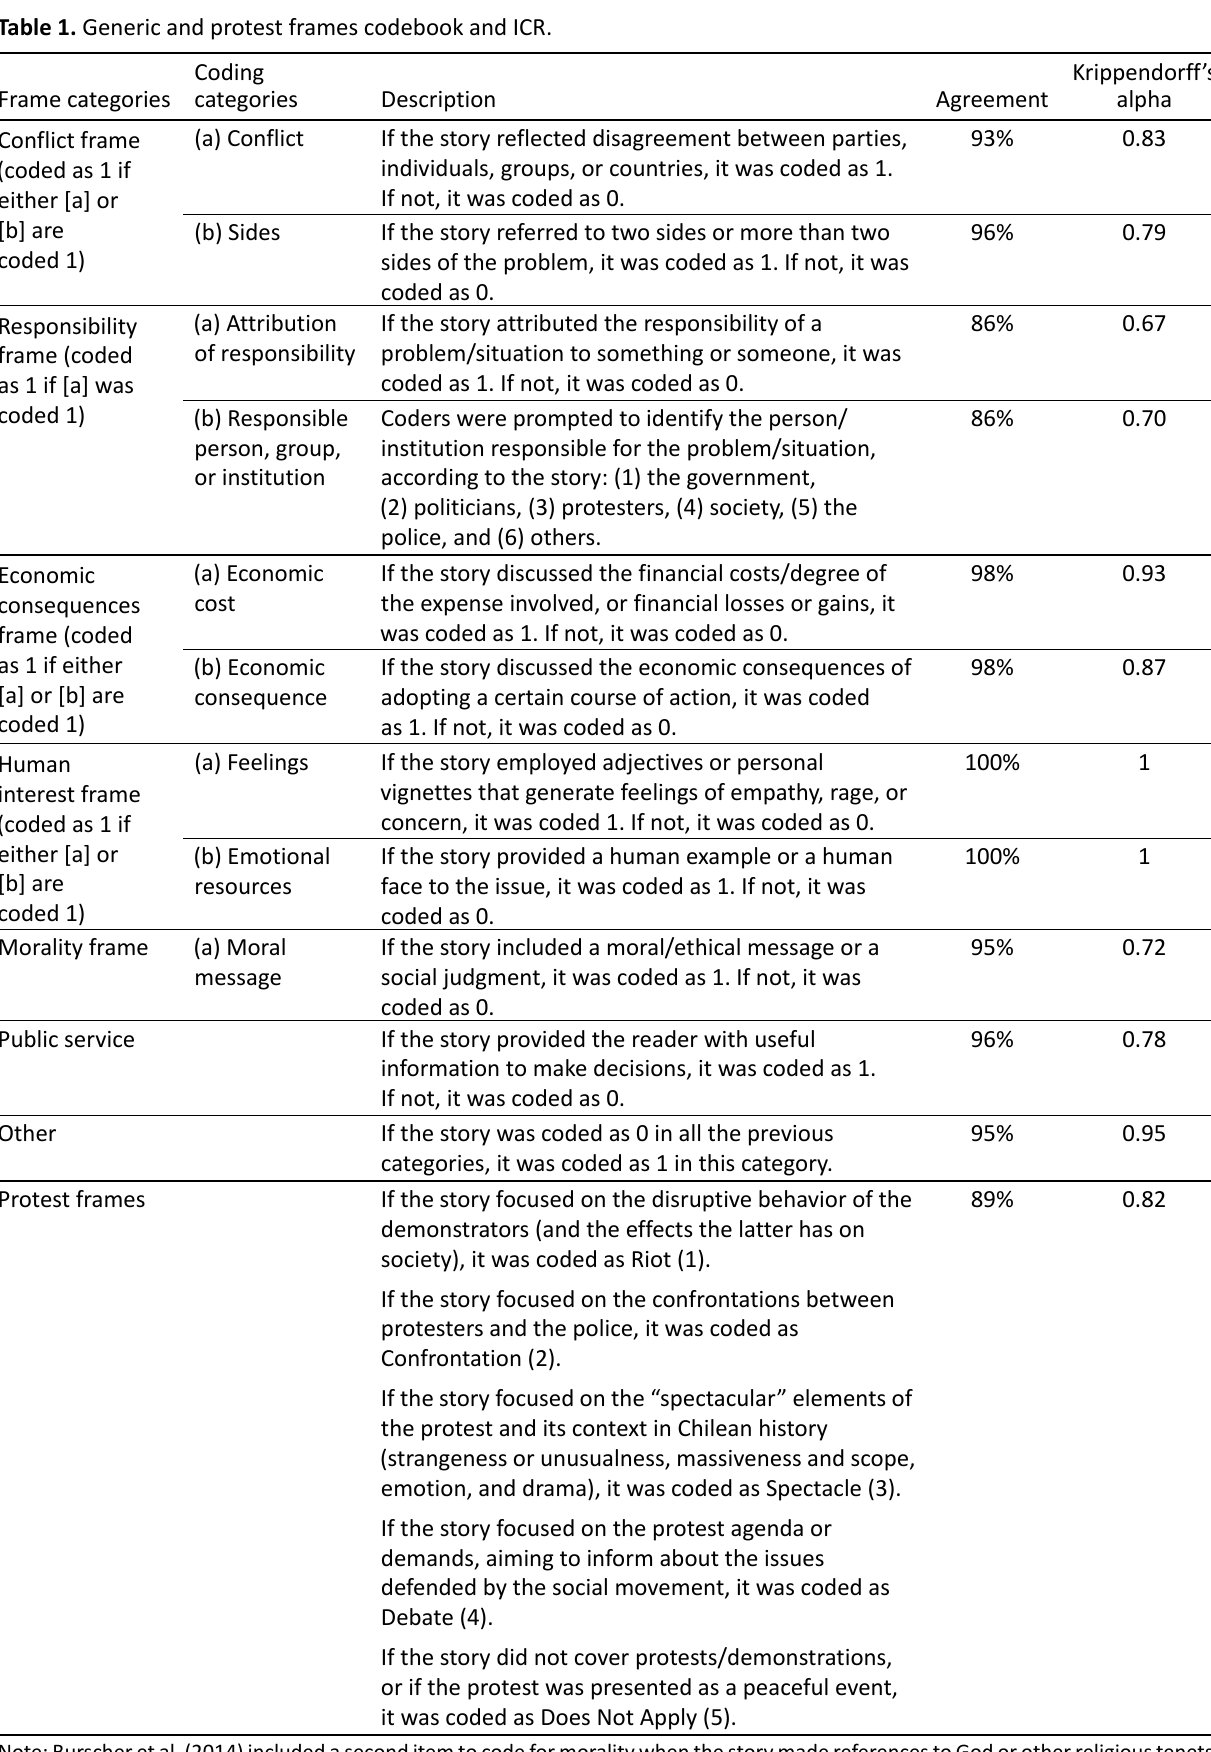
Table 1. Generic and protest frames codebook and